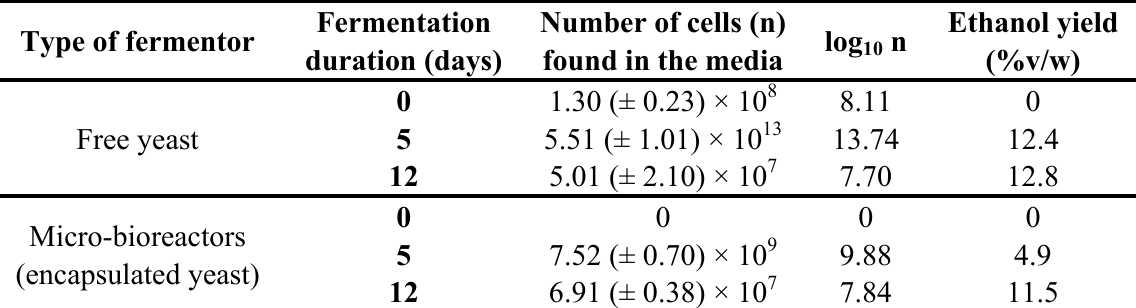
Table 2. Viable counts of free yeast cells in the fermentation media and their corresponding ethanol